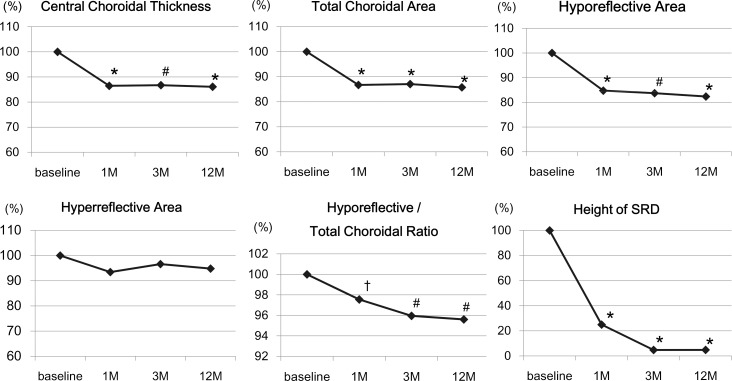
Time course of changes in EDI-OCT parameters.All parameters except the hyperreflective areas were significantly decreased from the baseline at 1 month and thereafter. Data are presented relative to that at the baseline. *P <0.001, #P <0.01, †P <0.05.